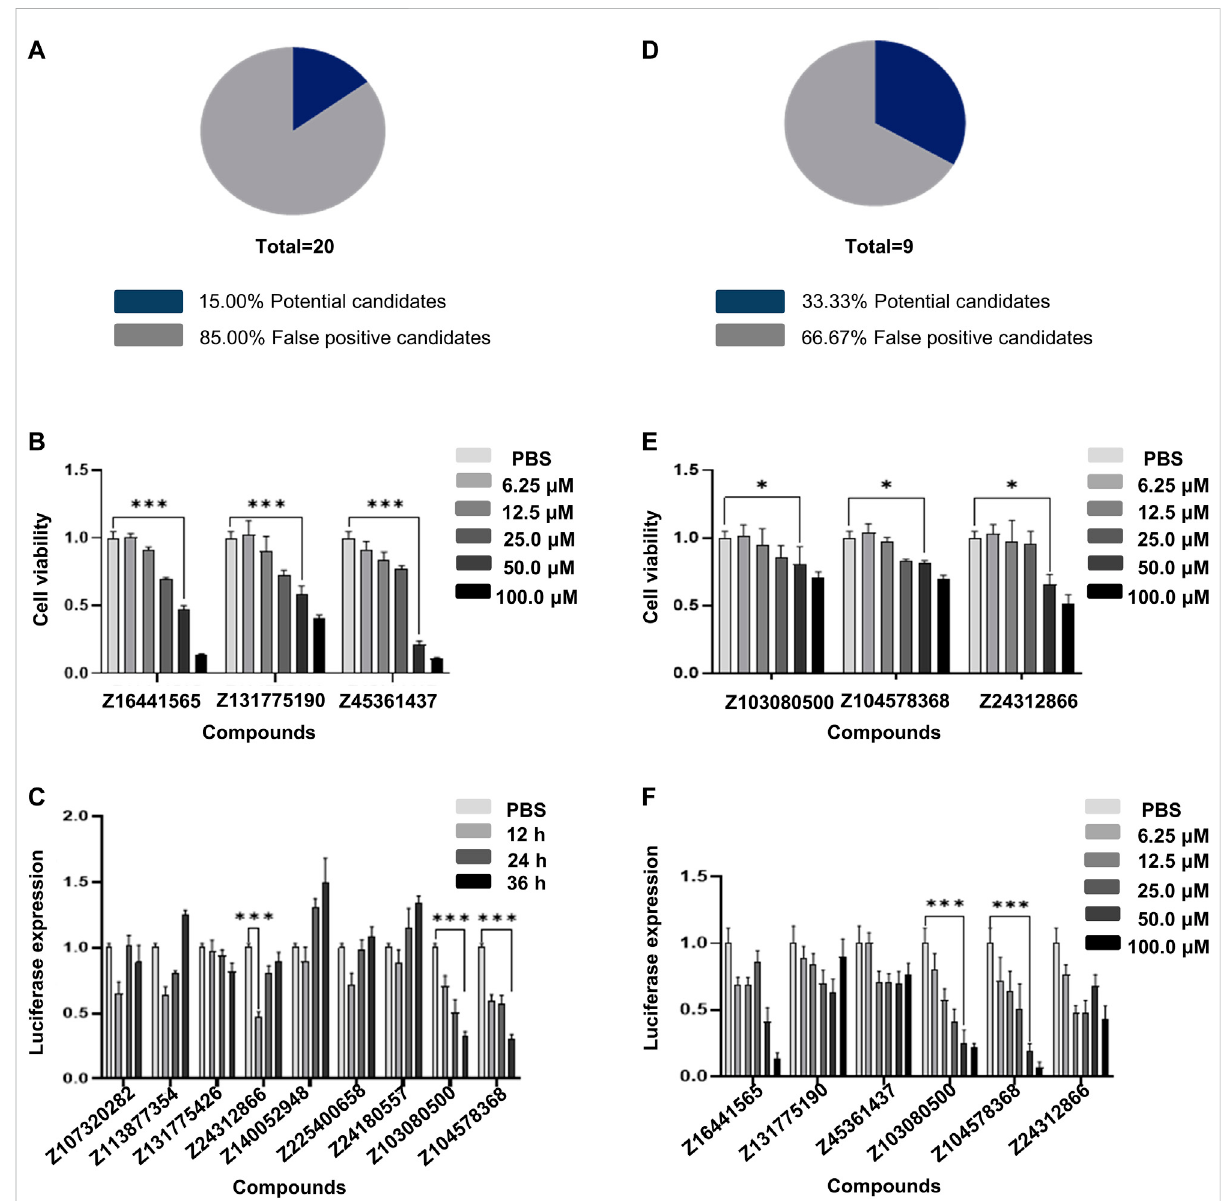
FIGURE 3 High-throughputscreeningusingCollagen1A2-A549cells. (A) Falsepositiveratecalculatedwith20compoundsselectedfromthe fi rstroundof calculation. (B) CCK8cytotoxicity resultsofthethreecompoundswithbetterperformanceamongthe20compoundsselectedinthe fi rstround. (C) Validationofninecompoundsselectedfromthesecondroundofcalculation. (D) Falsepositiveratecalculatedinthesecondroundofcalculation. (E) CCK8 cytotoxicity results of the three compounds with better performance among the nine compounds selected in the second round of calculation. (F) Validation of the concentration gradient of six compounds selected by two rounds of calculation for anti-collagen generation. All experiments were repeated three times